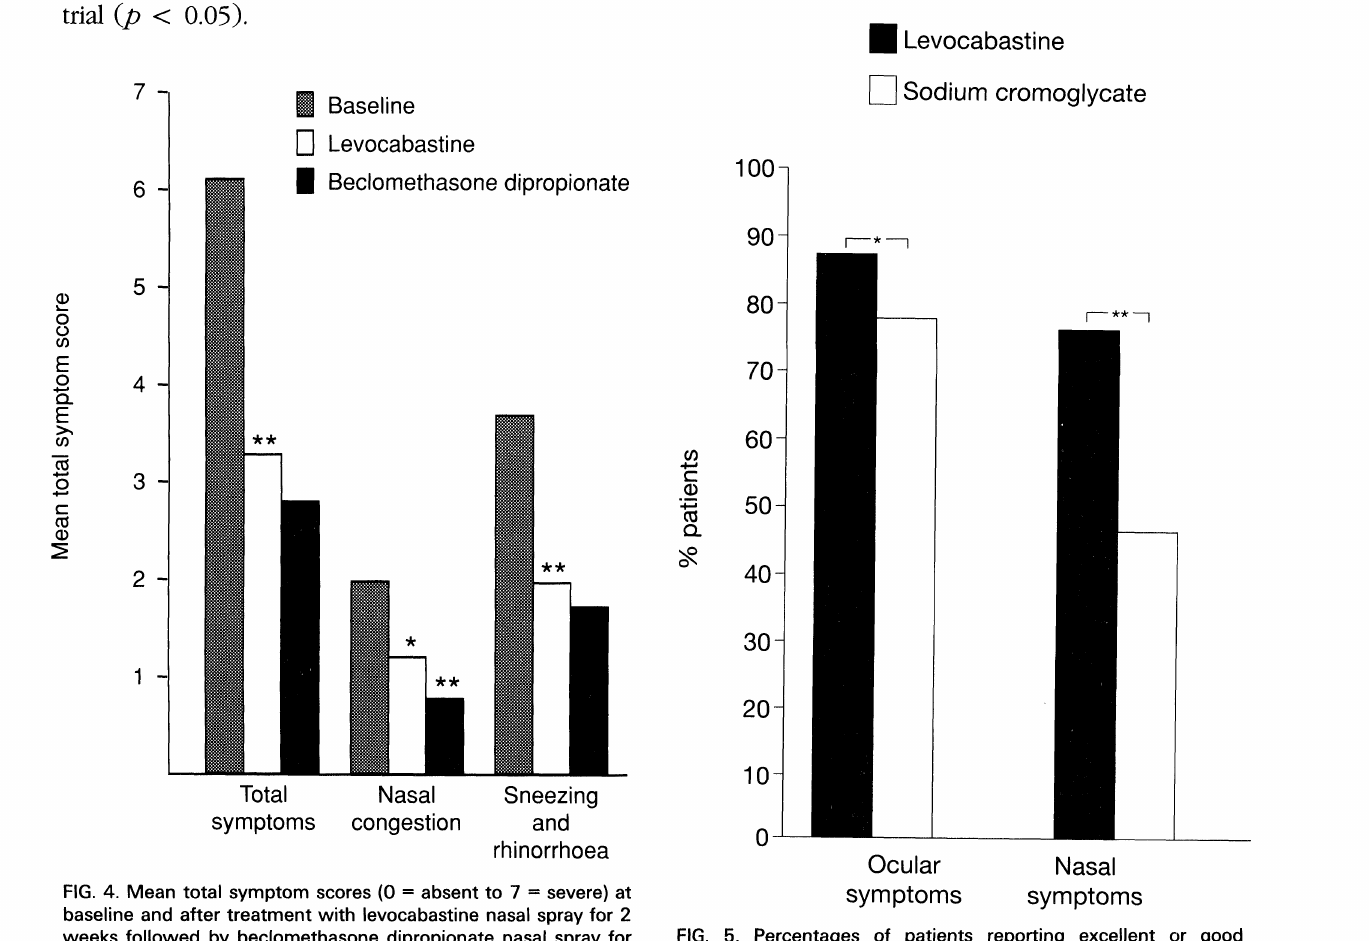
FIG. 5. Percentages of patients reporting excellent or good 45 2 weeks, p < 0.05; **p < 0.001 versus baseline. Repro- global therapeutic efficacy after 2 weeks of topical treatment with levocabastine or sodium cromoglycate. 46-49 Reproduced with permission. Mediators of Inflammation Vol 4 (Supplement).